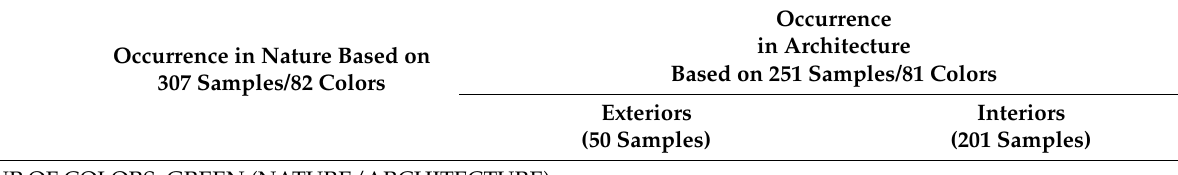
Table 1. The comparison of the occurrence of colors in the nature and the architecture of the examined buildings. Predominant Colors Identified through the